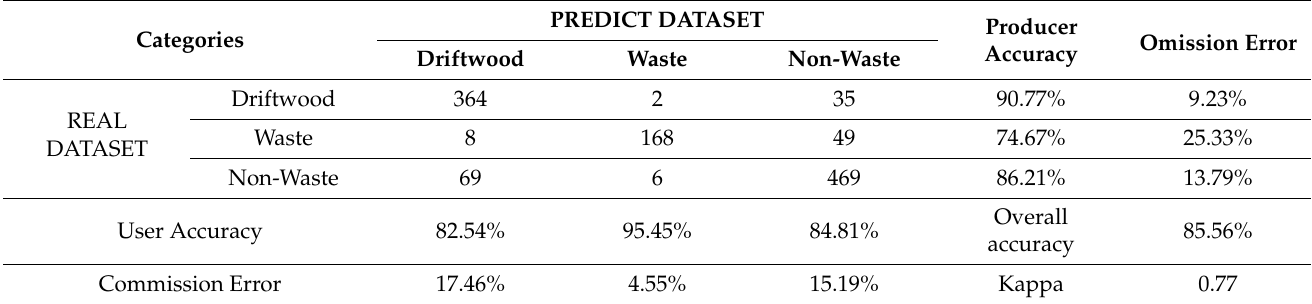
Table 2. Confusion matrix for